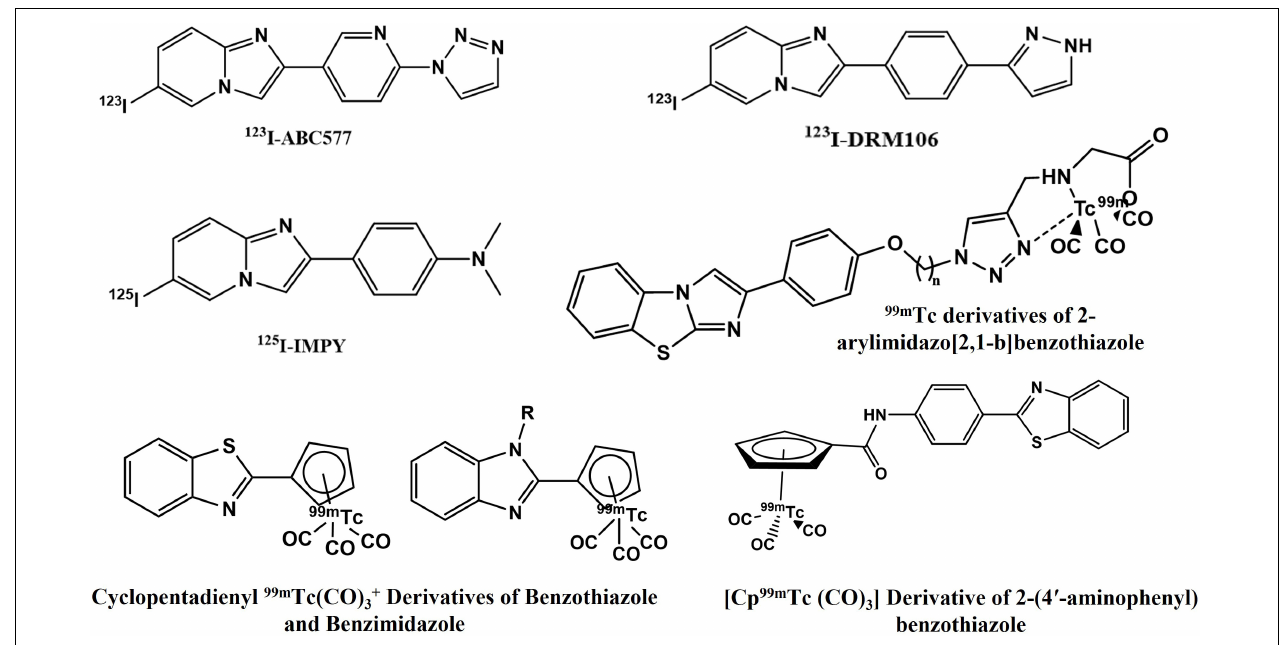
FIGURE 1 | A β 42 -specific single photon emission computed tomography (SPECT) imaging probes.